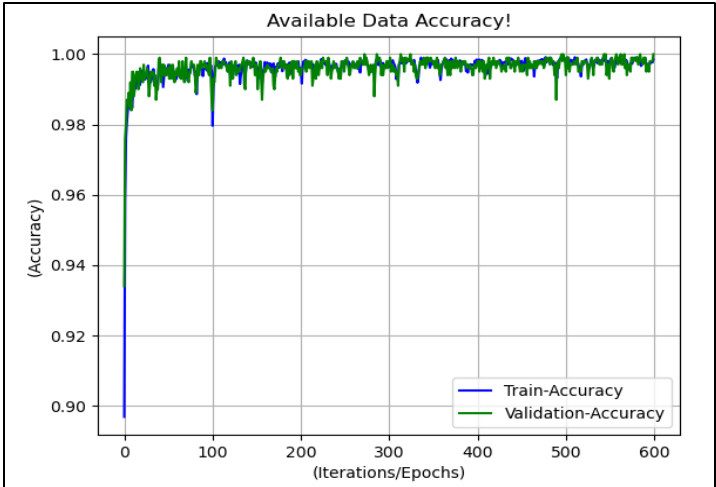
Figure 31. Training accuracy ANN model training in Raspberry PI.